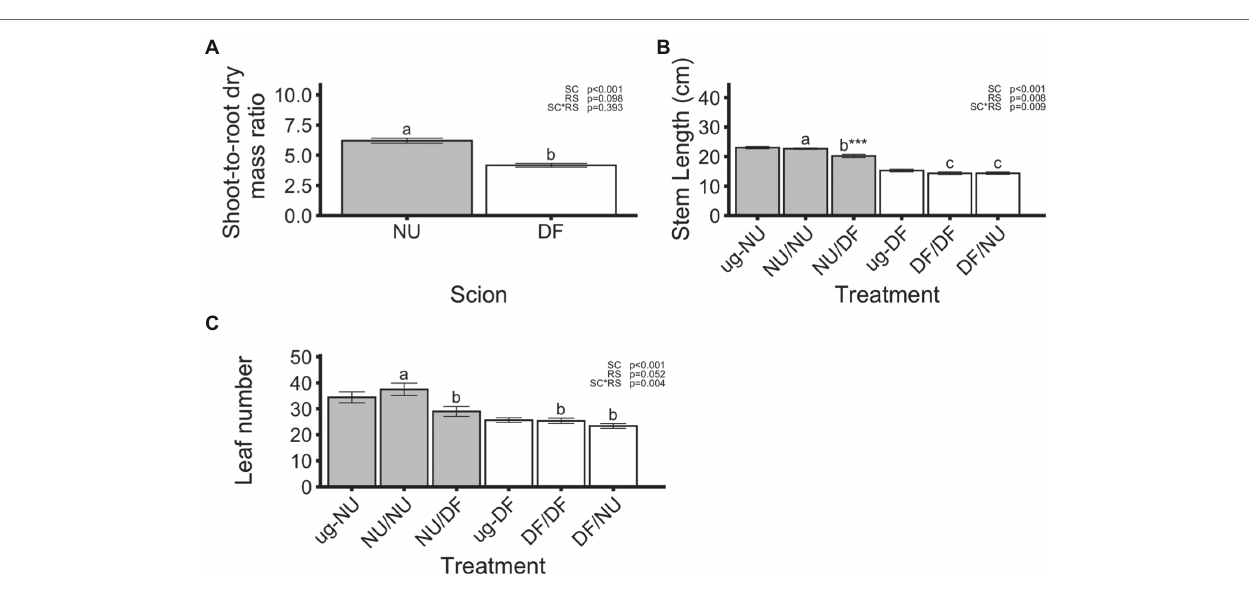
FIGURE 2 | Shoot-to-root dry mass ratio (A) and main stem length (B) from both trials, and number of leaves, exceeding 2 cm, in the second (C) trial. Values are means of 24 (A) , 12 (B) or 6 (C) replicates for each scion (A) or treatment (B,C) and error bars represent standard error. Asterisks above bars indicate significant difference between grafted treatment and the un-grafted control of the same scion cultivar by Dunnett’s test [***( p ≤ 0.001), **( p ≤ 0.01), and *( p ≤ 0.05)]. p -values indicate significance of scion (SC), rootstock (RS) and scion by rootstock interaction (SCxRS) effects from the factorial analysis of self- and inter-cultivar grafted plants (four treatments excluding un-grafted controls). Letters indicate mean separations for the four grafted treatments by Tukey’s HSD (p ≤ 0.05) applied when SCxRS interaction was significant. Gray and white bars represent plants with NU and DF shoot systems,